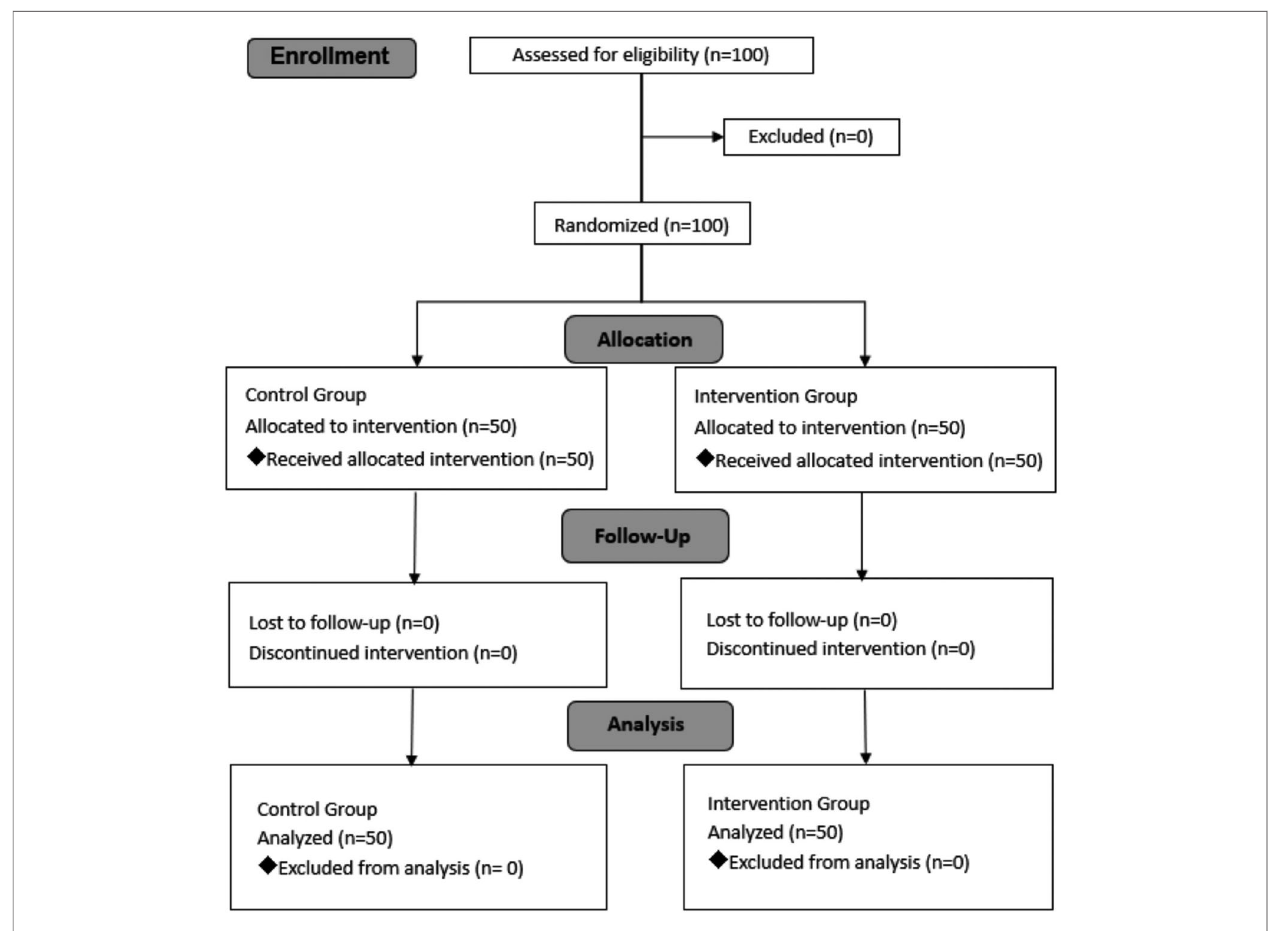
FIGURE 1 | CONSORT Flow Diagram.